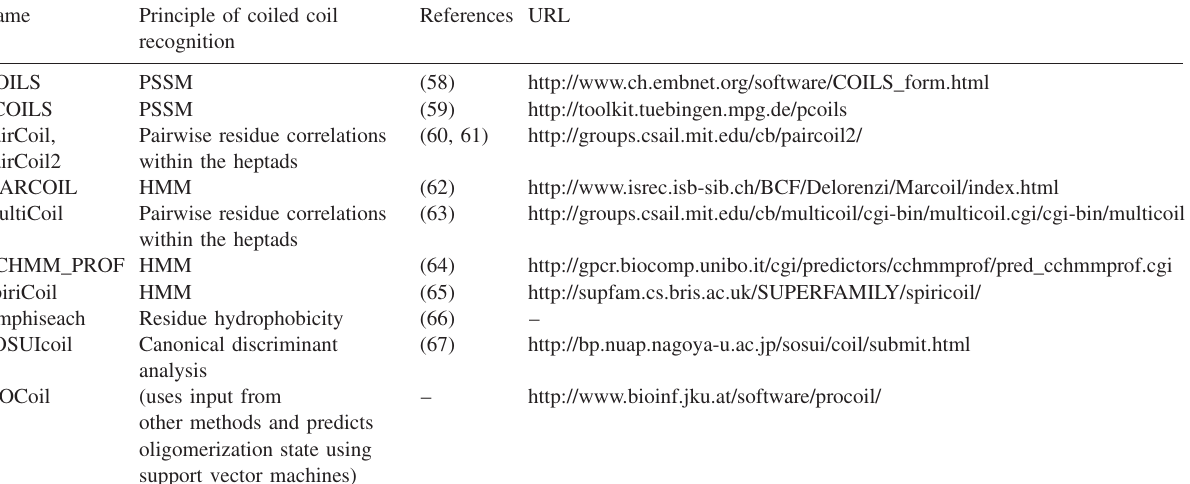
Table 1 List of several coiled coil prediction